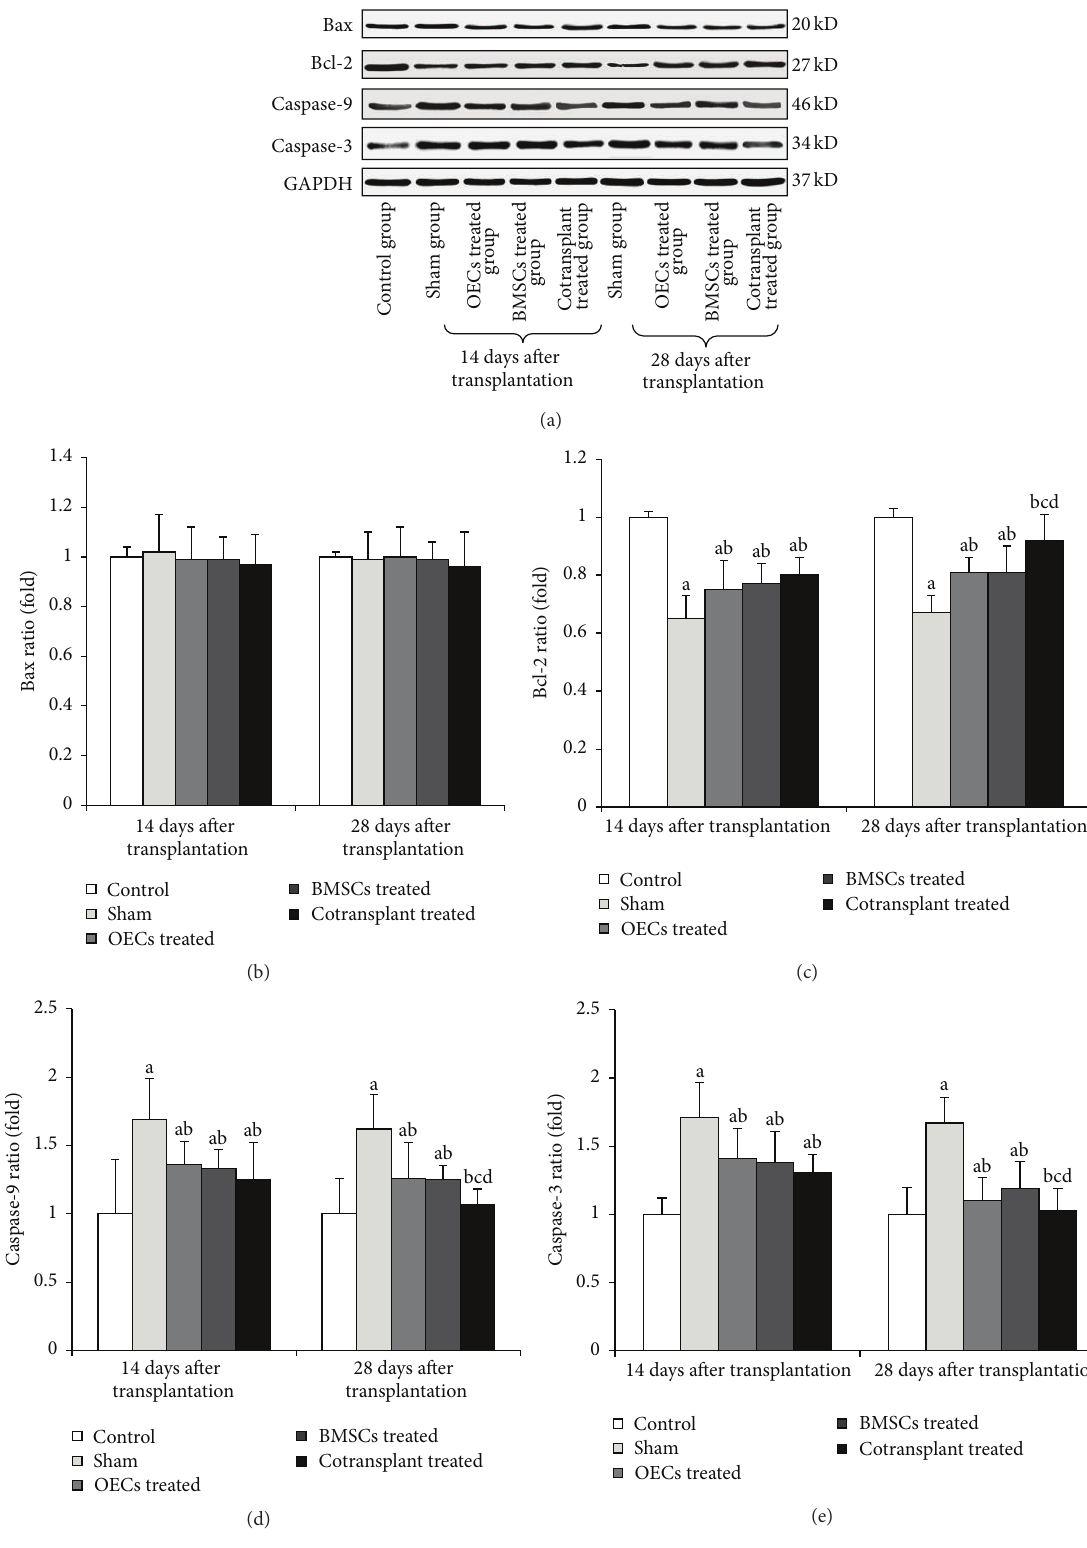
Figure 6: The expression on Bax, Bcl-2, Caspase-9, Caspase-3, and GADPH protein in spinal cord 14 days and 28 days after transplantation. (a)WesternblotanalysisofBax,Bcl-2,Caspase-9,Caspase-3,andGADPHproteinsofspinalcord.(b)RelativeratioofBaxprotein.(c)Relative ratio of Bcl-2 protein. (d) Relative ratio of Caspase-9 protein. (e) Relative ratio of Caspase-3 protein. a 𝑃 < 0.05 versus control group; b 𝑃 < 0.05 versus sham group; c 𝑃 < 0.05 versus OECs treated group; and d 𝑃 < 0.05 versus BMSCs treated